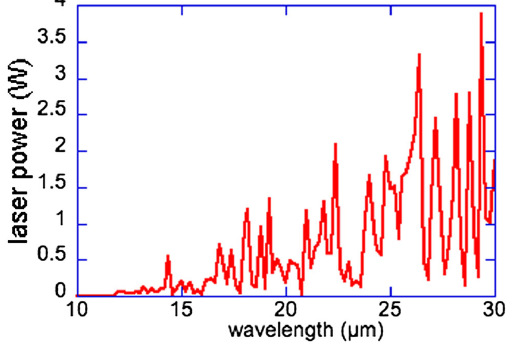
FIG. 21. Laser power versus wavelength.